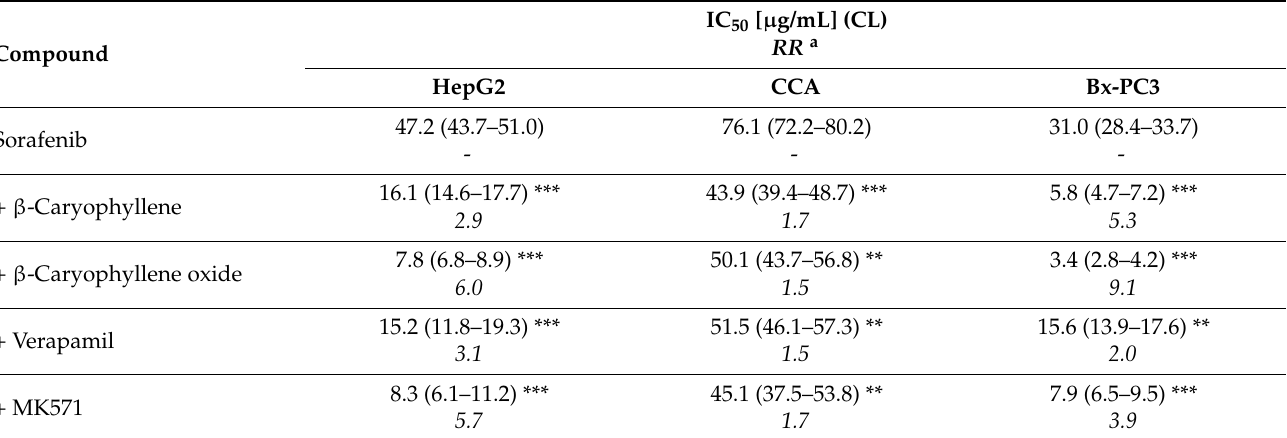
Figure 3. Cytotoxicity of sorafenib in combination with verapamil and MK571 ( A – C ), and the sesquiterpenes β -caryophyllene and β -caryophyllene oxide ( D – F ) in hepatoblastoma (HepG2), extrahepatic cholangiocarcinoma (Mz-ChA-1), and pancreas adenocarcinoma (Bx-PC3) cells after 4 h exposure and 72 h recovery time. Data displayed as mean ± SE of at least three independent experiments ( n = 3). Table 3. IC 50 values of sorafenib and its combination with β -caryophyllene, β -caryophyllene oxide, verapamil, and MK571 under the scheduled protocol.